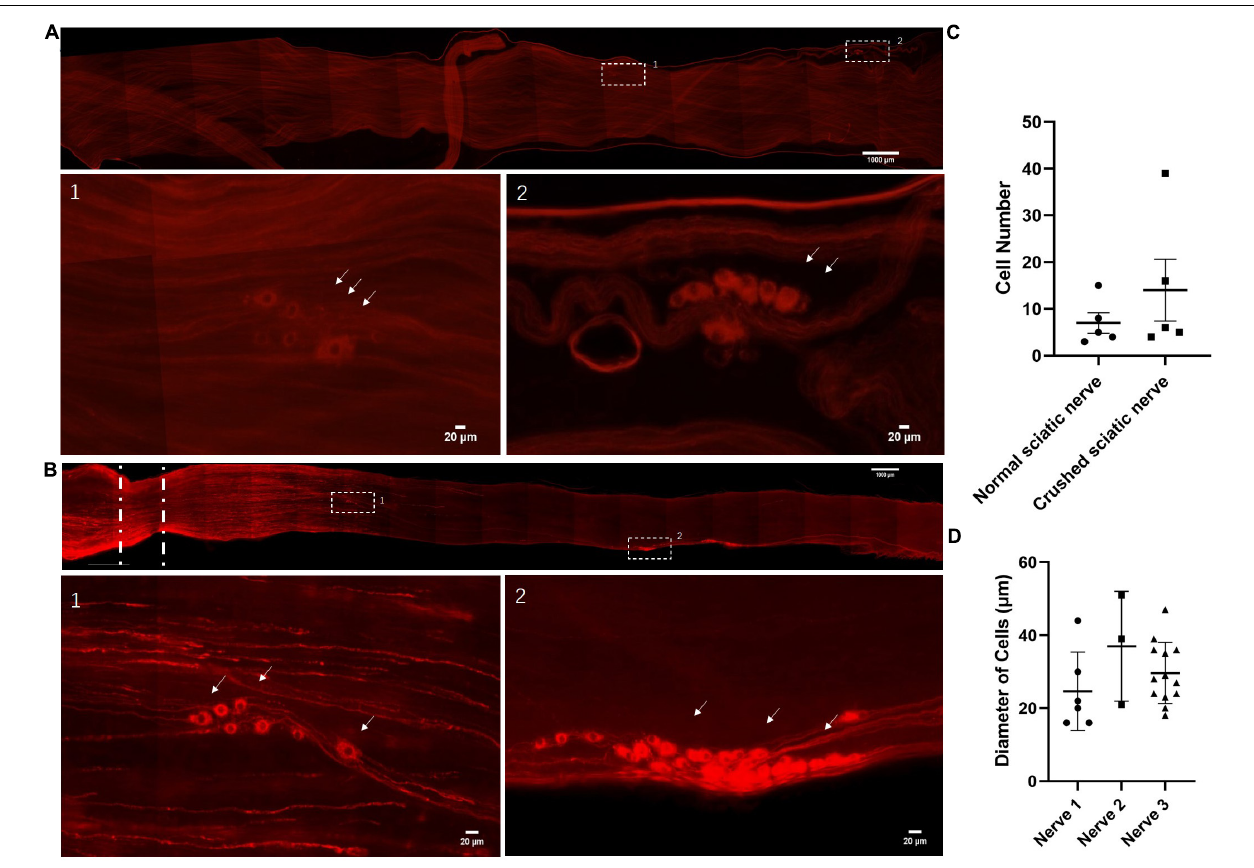
FIGURE 1 | Identification of neuronal cells in the sciatic nerves of adult rats. (A) Neuronal cells in the intact sciatic nerves of adult rats. The nerves were hyalinized using ScaleS and stained for Stmn2 (red). n = 18 (totally), n = 5 (sciatic nerves with neuronal cells). Scale bar: upper = 1000 µ m, lower = 20 µ m. (B) Neuronal cells in the crushed sciatic nerves of adult rats. Lower panels show high-magnification images of the boxed regions in the upper panel. The sciatic nerves were hyalinized using ScaleS and stained for Stmn2 (red). The white lines indicated the crush site. n = 16 (totally), n = 5 (sciatic nerves with neuronal cells). Scale bar: upper = 1000 µ m, lower = 20 µ m. (C) The quantification of Stmn2 + cell number in the normal sciatic nerves and crushed sciatic nerves. The circle points represent the number of Stmn2 + cells of a normal sciatic nerve. The square points represent the number of Stmn2 + cells of a crushed sciatic nerve (Normal sciatic nerves: n = 5 of 18 which contain neuronal cells, crushed sciatic nerves: n = 5 of 16 which contain neuronal cells; p > 0.05; unpaired t test). (D) The quantification of diameters of Stmn2 + cells in the sciatic nerves ( n = 3; p > 0.05; one-way ANOVA with Dunnett’s multiple comparisons test). The white arrow points to the positive